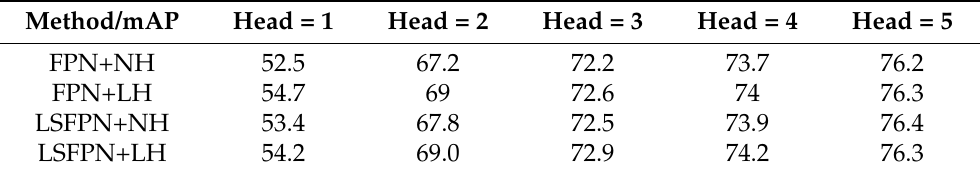
Table 8. Ablation experiment of LSFPN and LH.